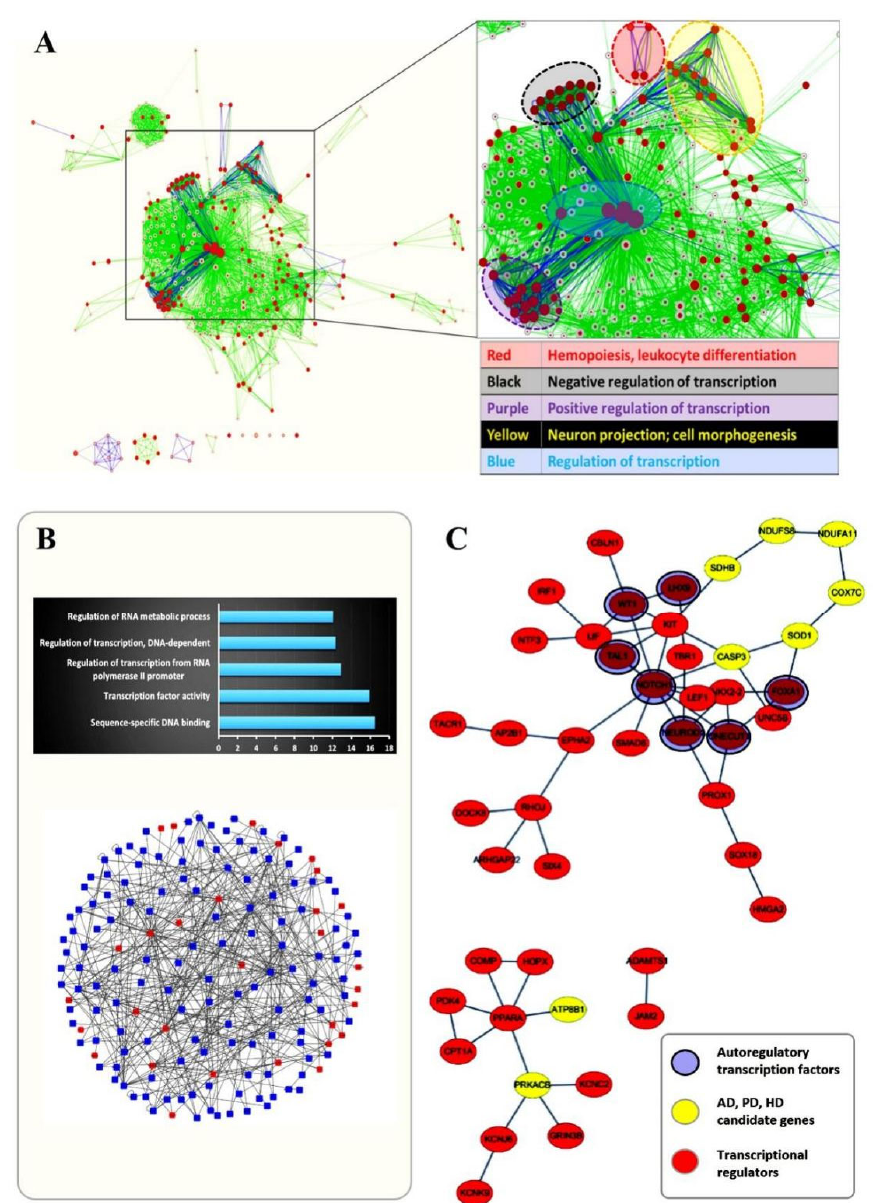
Figure 3. The correlation between chromatin bivalency and 3OHB‑perturbed gene expression patterns highlighted that the 3OHB‑sensitive transcriptional regulatory network is a promoter of the interaction between disease‑related genes and 3OHB. ( A ) Biological processes associated with H3K27me3‑H3K4me3 chromatin bivalency and processes perturbed by ketone bodies (1 mM 3OHB and 1 mM acetoacetate, 1 h) in neurons were extracted and overplayed to reveal possible correlations between chromatin bivalency and 3OHB. ( B ) Up, the overlapping genes were further subjected to gene ontology analysis; down, the protein‑protein interaction network was seeded with the overlapping genes. Red nodes indicate seed genes and blue nodes represent intermediate